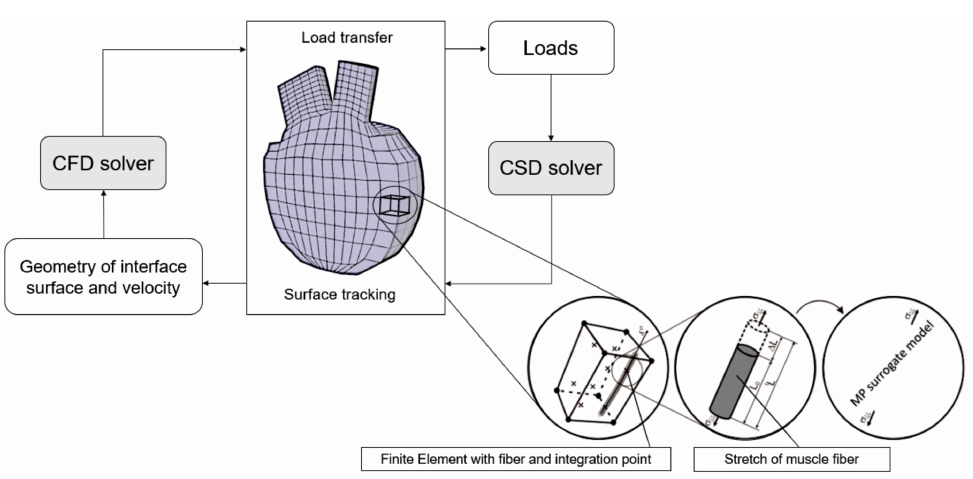
Figure 1. Block diagram of the FSI algorithm coupled with multi-scale model of muscle contraction. Muscle is discretized into FEs where each FE contains muscle fiber and integration points [26].